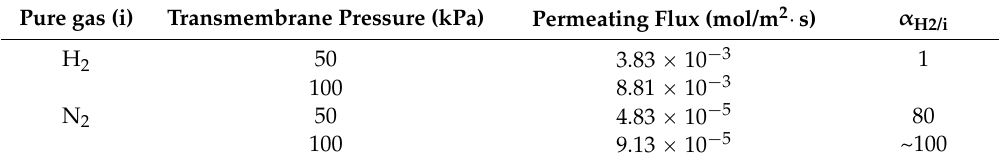
Table 1. H 2 and N 2 permeating flux at 350 °C with the Pd ‐ Au/PSS membrane at the onset of the experimental testing.